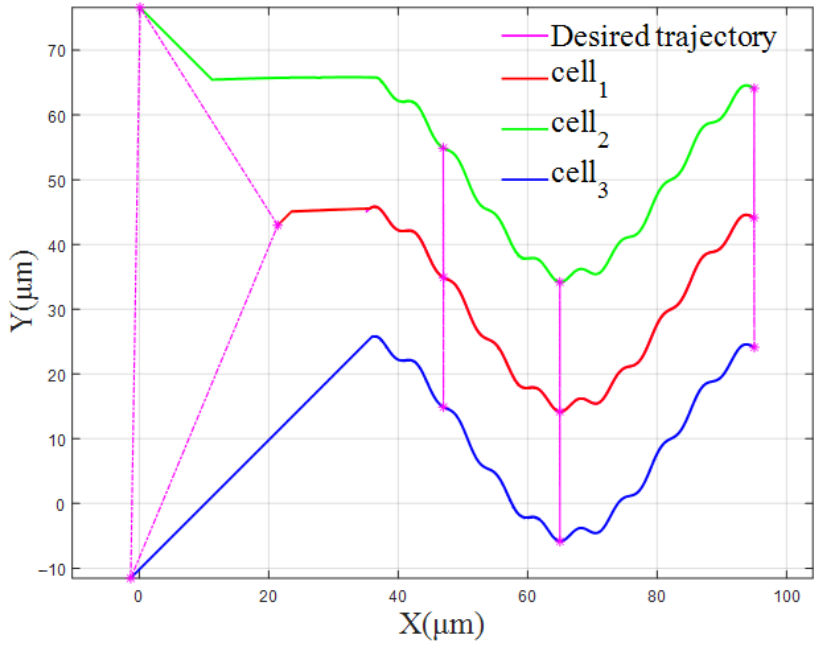
Figure 14. The cell trajectory of the vertical formation ( β /k = 0.09).